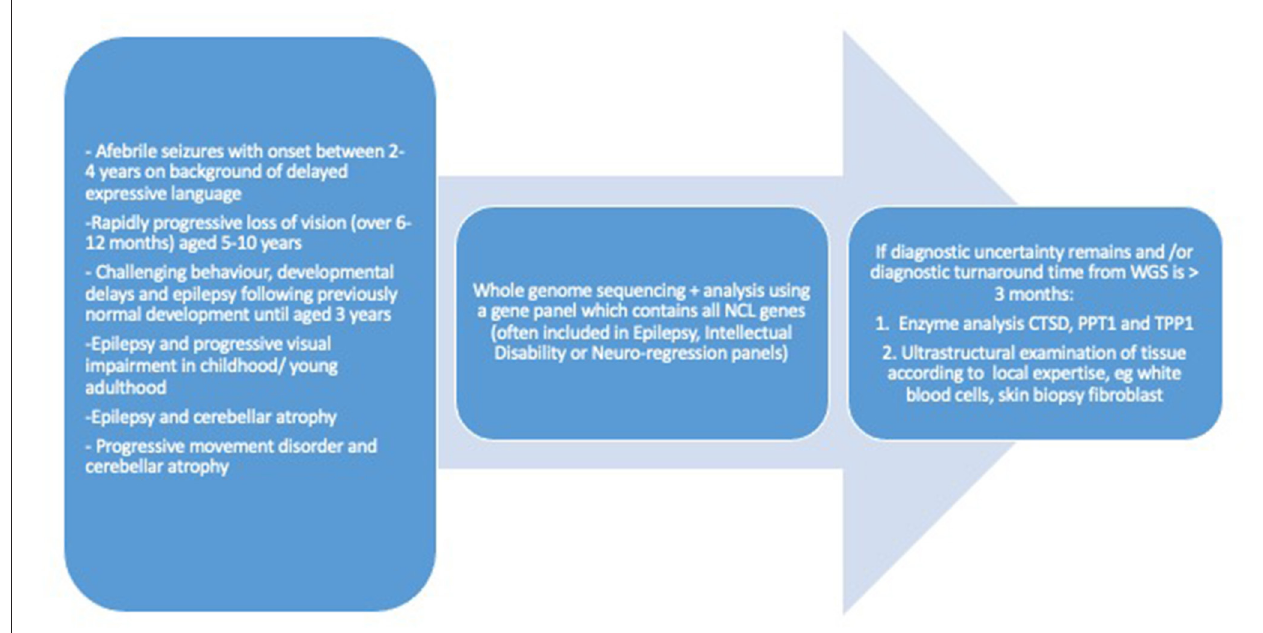
FIGURE 2 | Diagnostic work up for neuronal ceroid lipofuscinosis of childhood